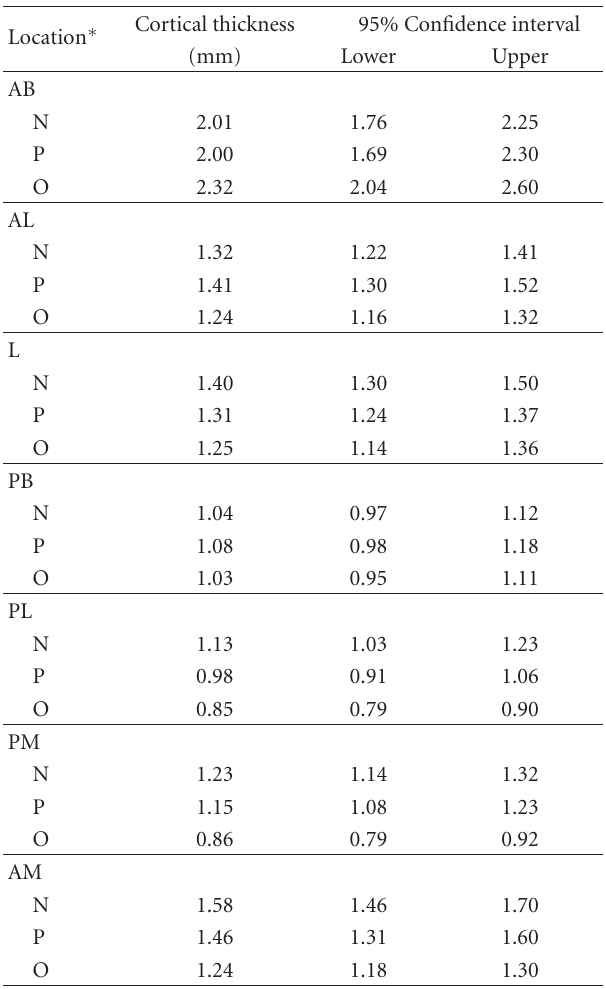
Table 3: Cortical thickness by region and